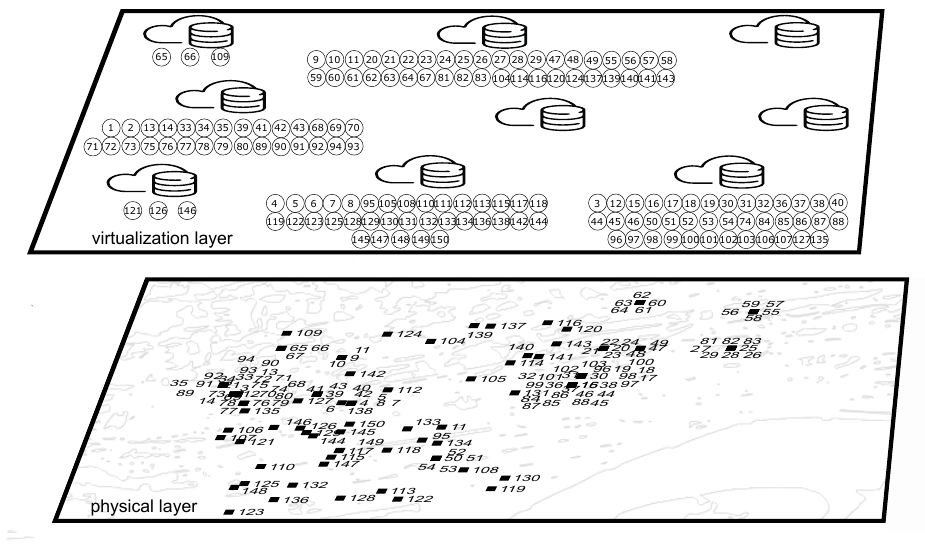
Figure 4. SDTs placement in the edge infrastructure for SoCEP with Γ = 40, L max = 5 ms.